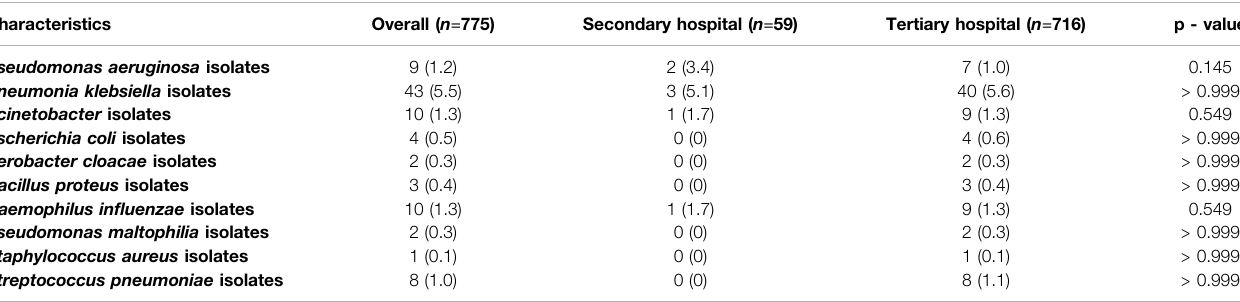
( Table 4 ). A total of 775 AECOPD patients had bacterial culture results during admission. The most common bacterial pathogens